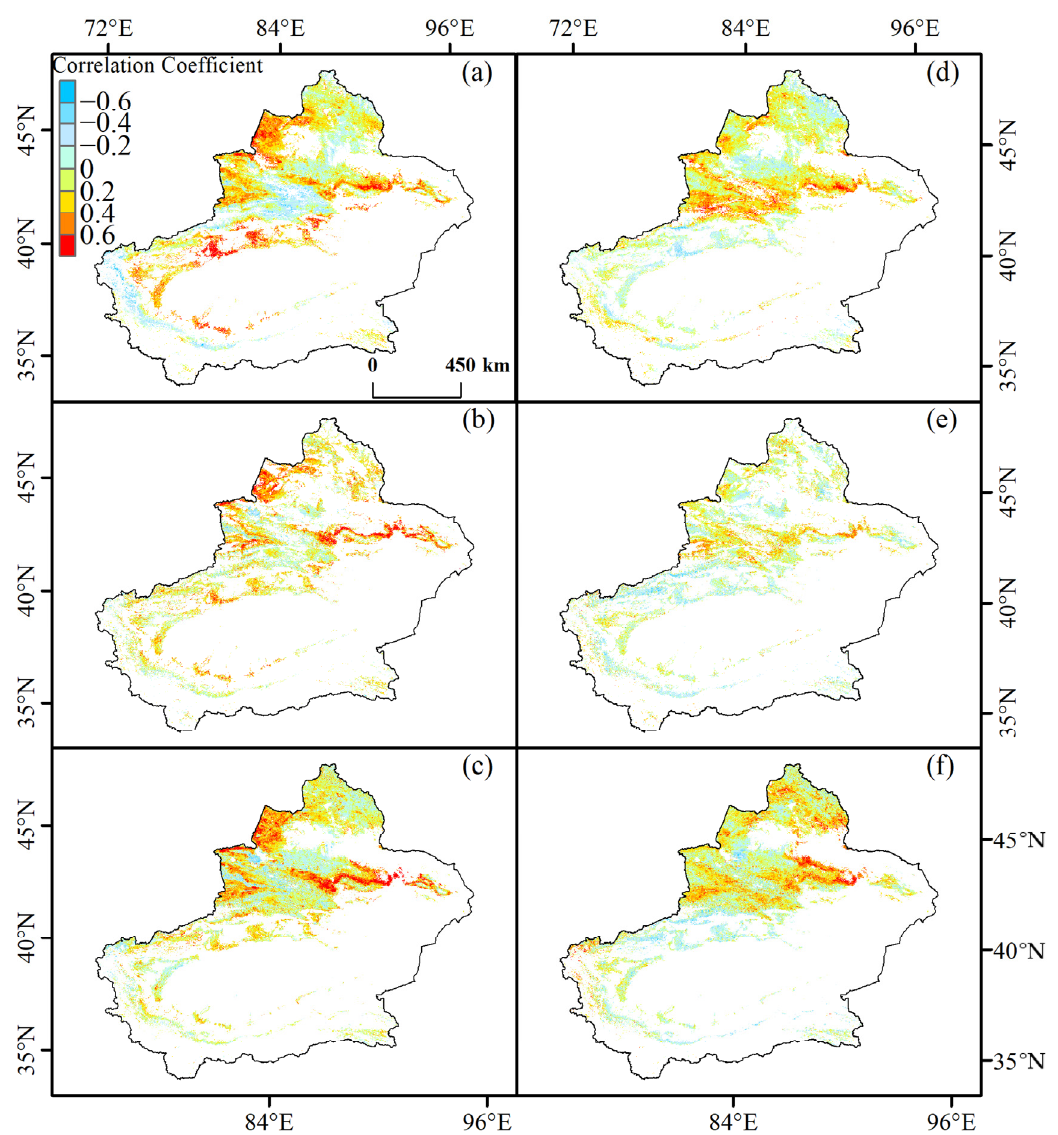
Figure 11. Spatial pattern of the correlation between precipitation, temperature, and ecosystem indicators from 2001 to 2015. ( a ) Precipitation-ET, ( b ) Precipitation-GPP, ( c ) Precipitation-LAI, ( d ) Temperature-ET, ( e ) Temperature-GPP, and ( f ) Temperature-LAI.